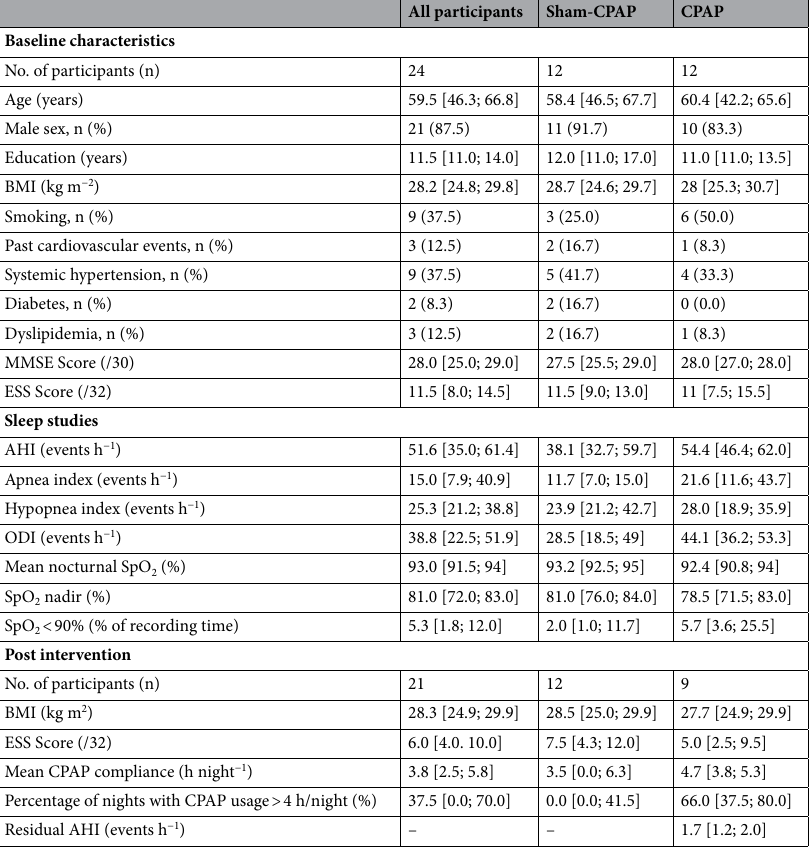
Table 1. Participants characteristics, obstructive sleep apneas characteristics at baseline and after 8 weeks of CPAP or Sham-CPAP. AHI apnea–hypopnea index, BMI body mass index, CPAP continuous positive airway